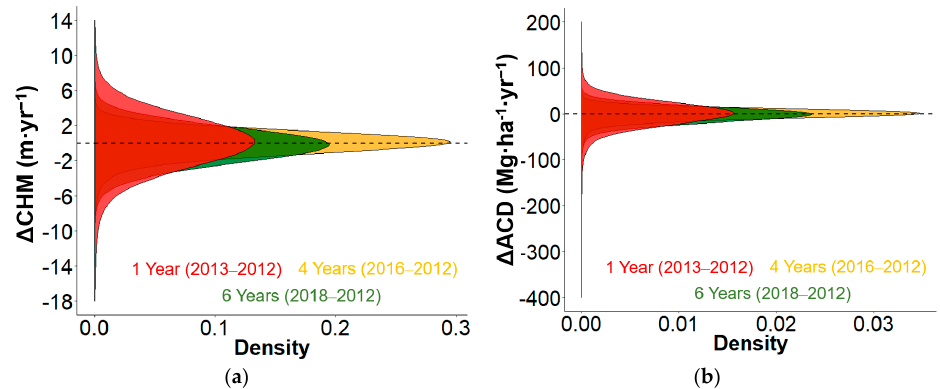
Figure 5. Frequency distribution of pixel counts of gains and losses in ( a ) net height and ( b ) net carbon density for different time intervals in the HMTF area. Each color represents a period and all the values are normalized by the respective time interval. The dashed line separates the positive (gain) and negative (loss) values.